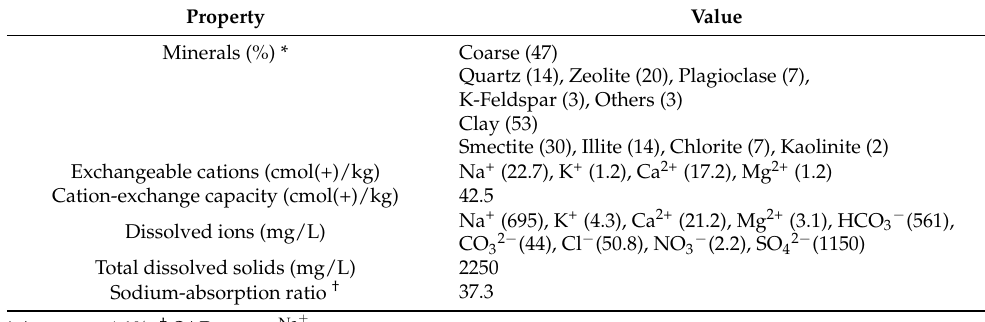
Table 1. Summary of soil and pore-water